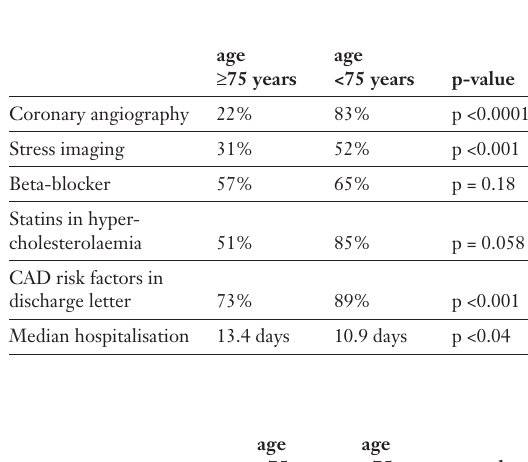
Results of patients without comorbidity in the ACS